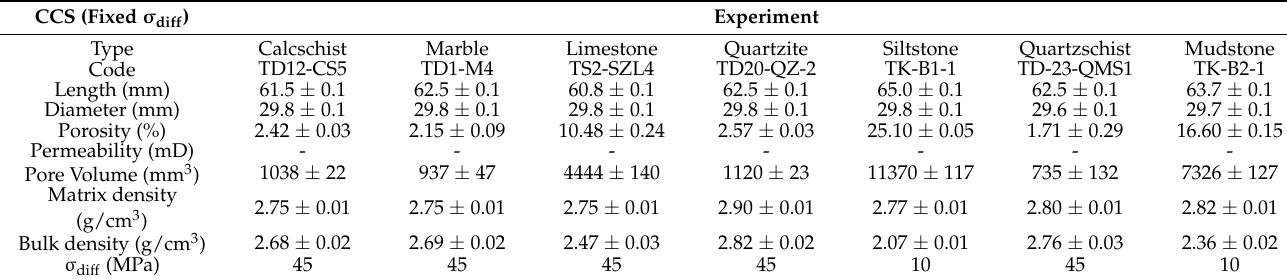
Table 4. Properties of the core samples used in experimental series C: CCS tests (fixed σ diff ).